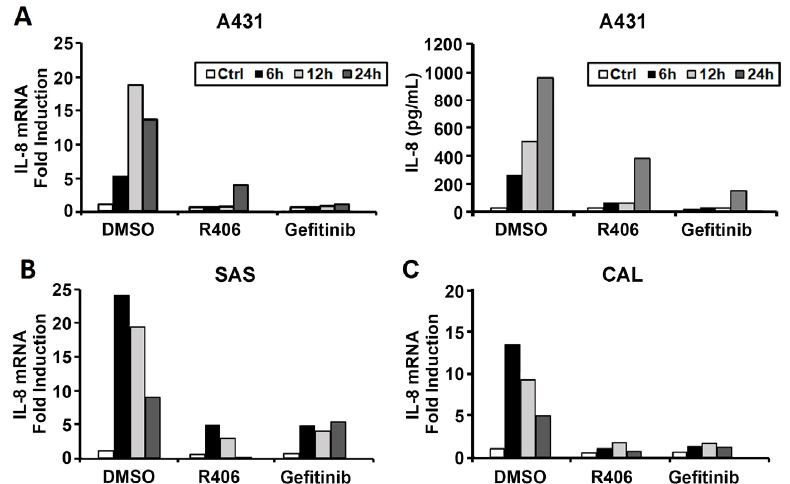
Figure 3. Syk mediates EGF-induced IL-8 mRNA and protein expression in SCC. EGF (100 ng/mL) treatment in A431 ( A ), SAS ( B ), and CAL27 ( C ) cells for 0, 6, 12, and 24 h and the addition of R406 (1 µ M) or gefitinib (5 µ M) as a positive control. IL-8 mRNA levels were determined by RT-PCR and protein levels by ELISA.